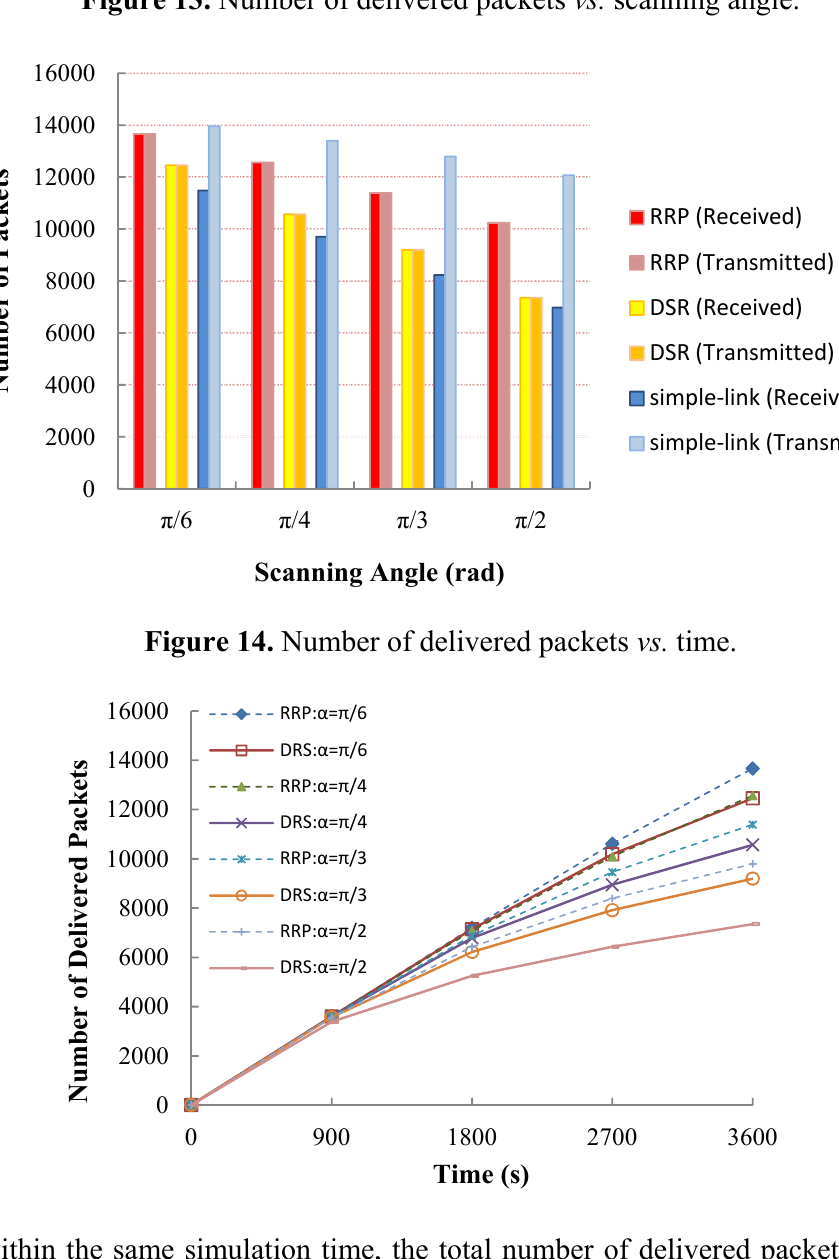
Figure 13. Number of delivered packets vs. scanning angle.